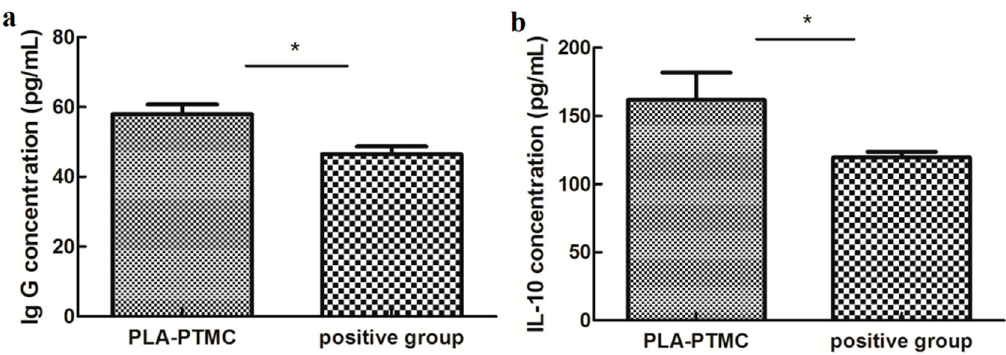
Figure 11. The results of ELISA testing. ( a ) is the difference of rabbit immunoglobulin G (IgG), and ( b ) is the statistical difference of rabbit interleukin 10 (IL-10). Values are the means ± S.E.M. ( n = 5). * p < 0.05 compared with the control group; * p > 0.05 was considered not to be statistically different. These indicators were detected using kits that were obtained from CUSABIO (CUSABIO, Wuhan, China).